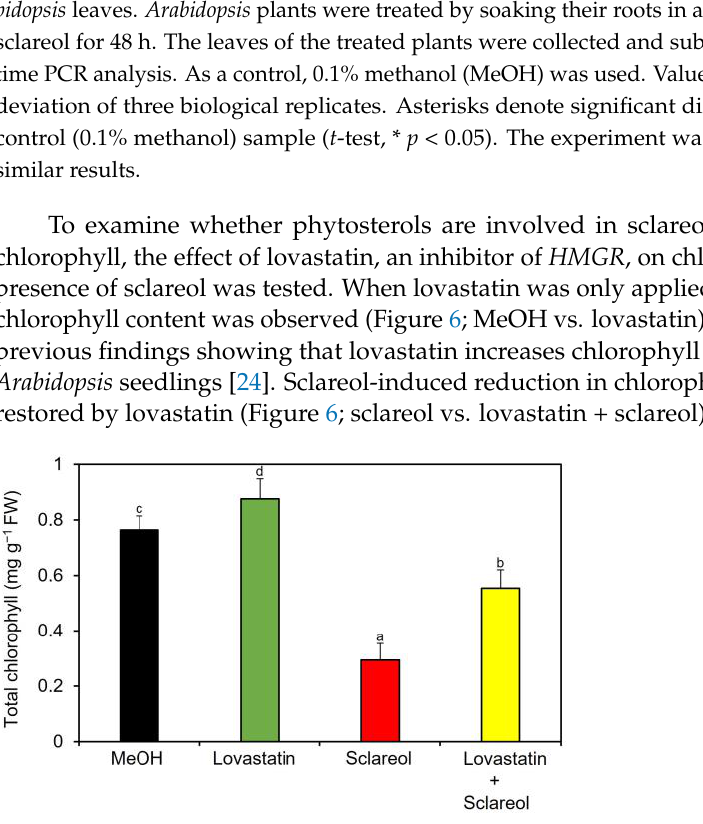
Figure 6. Effect of lovastatin on sclareol-induced reduction in chlorophyll. Arabidopsis plants were treated by soaking their roots in a solution containing 100 µ M lovastatin, 100 µ M sclareol, or a 50:50 mixture of lovastatin and sclareol for 48 h. The leaves of the treated plants were collected and the contents of total chlorophyll, as represented as the sum of chlorophyll a and b, were measured. As a control, 0.1% methanol (MeOH) was used. Values are the means ± standard deviation of three biological replicates. Different letters indicate significant differences among treatments (Tukey’s test, p < 0.05). The experiment was repeated three times with similar